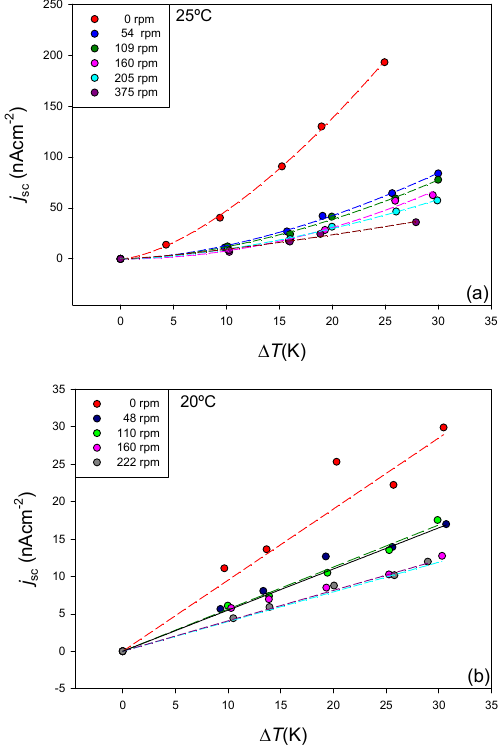
Figure 7. Short-circuit current density versus solution stirring rate for CR61 under different condi- tions: ( a ) Mean temperature: 25 °C; Lines corresponds to fit the experimental data to Equation (7). ( b ) Mean temperature: 20 °C. Lines correspond to linear fits.